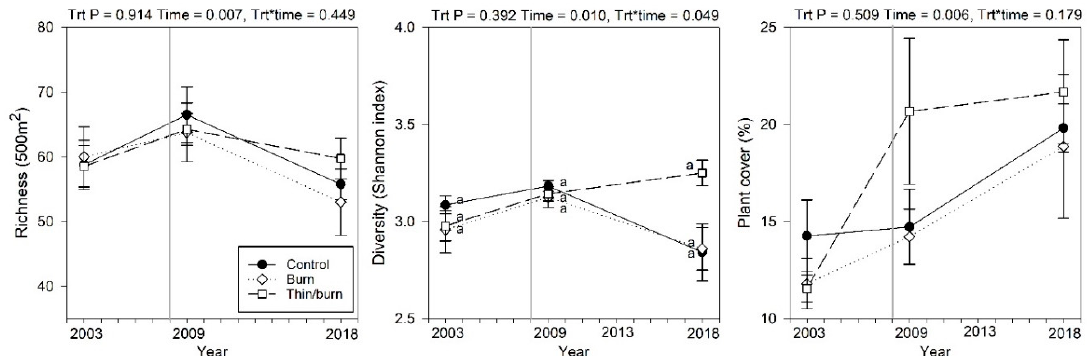
Figure 4. Mean herbaceous/prostrate shrub richness, diversity, and cover plotted through time for both treatments and the control. Bars represent 1 standard error of the mean ( n = 4). The vertical line denotes when all treatments were completed (2008). Data comparisons are among treatments and different letters denote a significant treatment effect within a year ( p ≤ 0.05).